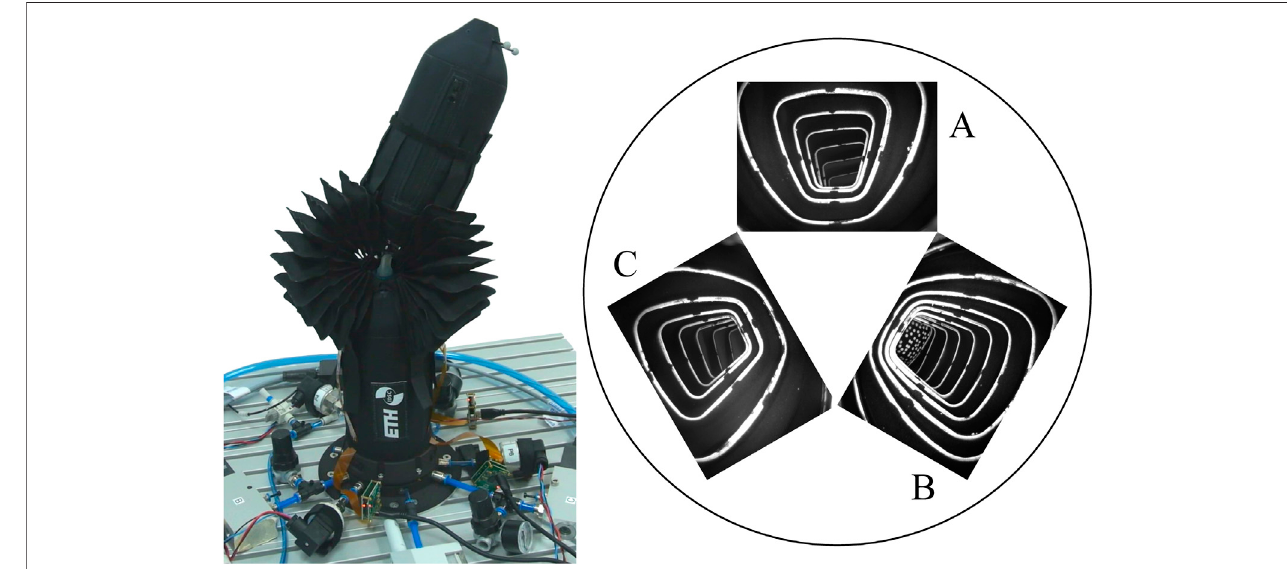
FIGURE1| The fi gureontheleftshowsthesphericalroboticarmusedforevaluationofthevision-basedsensingapproachproposedinthiswork.The fi gureonthe right shows images from the cameras placed inside three in fl atable bellow actuators. The arrangement of the camera images matches a view from the bottom looking upwards. The orientation of the movable link can be observed in certain actuator elongations and deformations that are observed by the internal cameras.